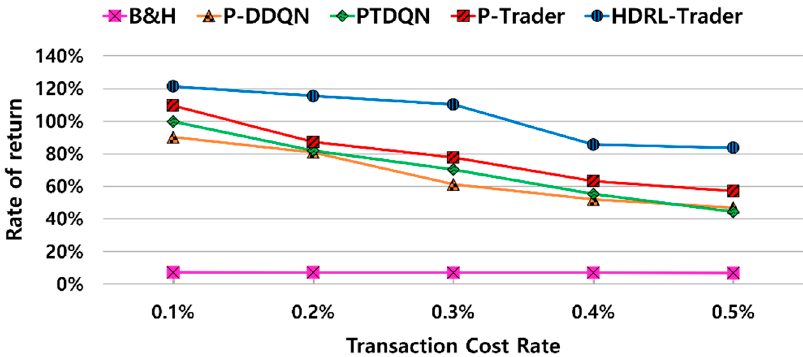
Figure 16. Experimental results of robustness study.